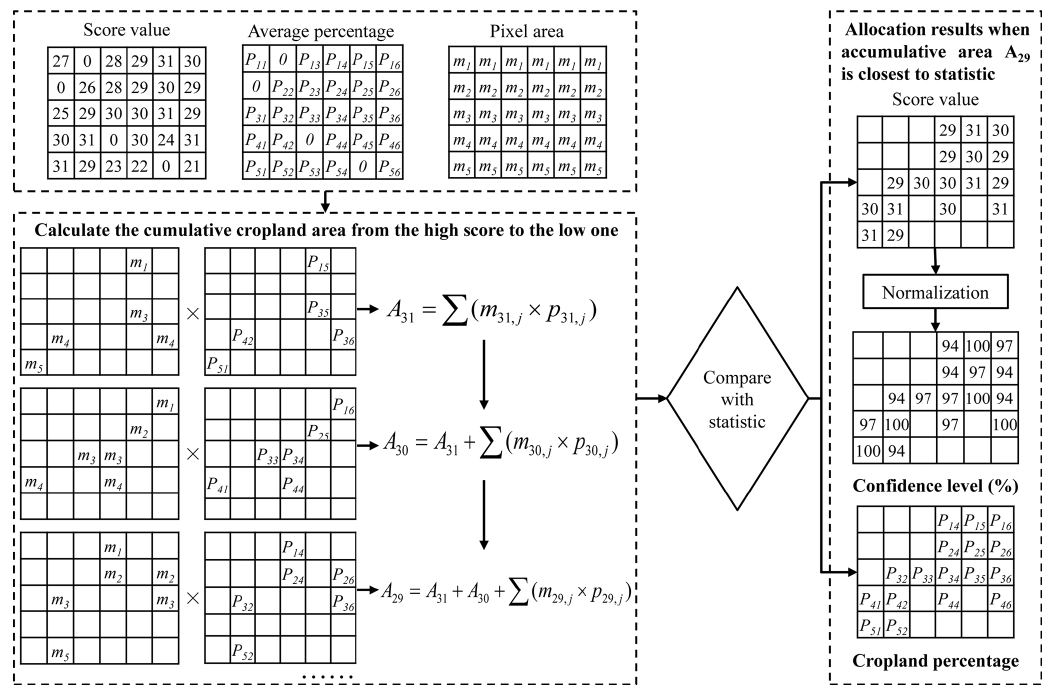
Figure 2. The flowchart of cropland area statistics allocation with five input